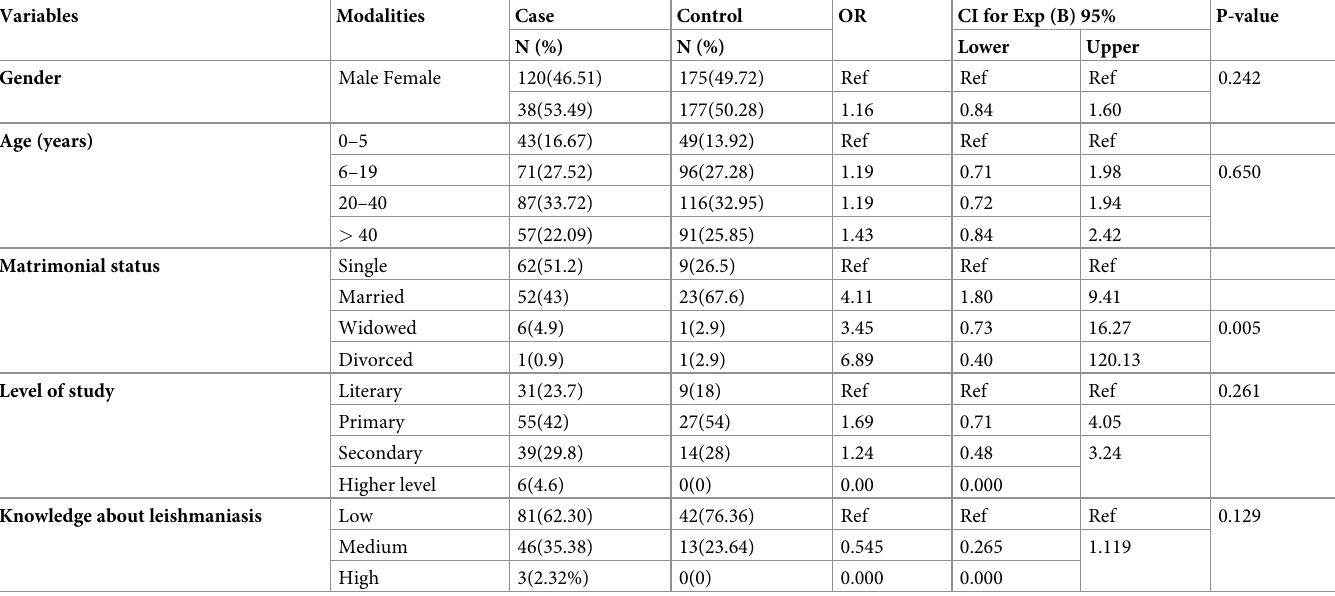
Table 1. Socio-demographic determinants associated with ACL, in the Marrakech-Safi region, Morocco between 2018 and 2020.